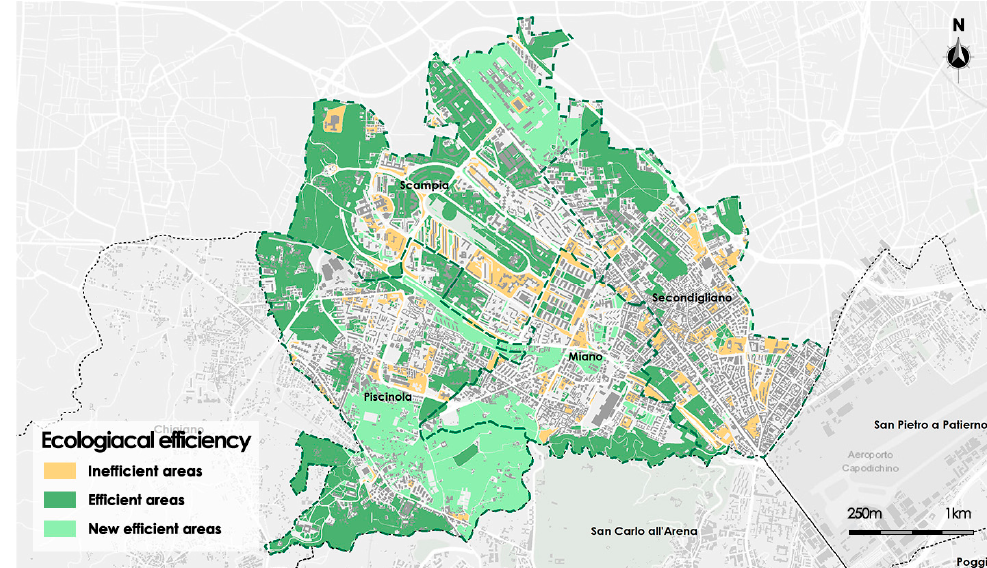
Figure 7. Spatial distribution of ecologically efficient areas after planting works.